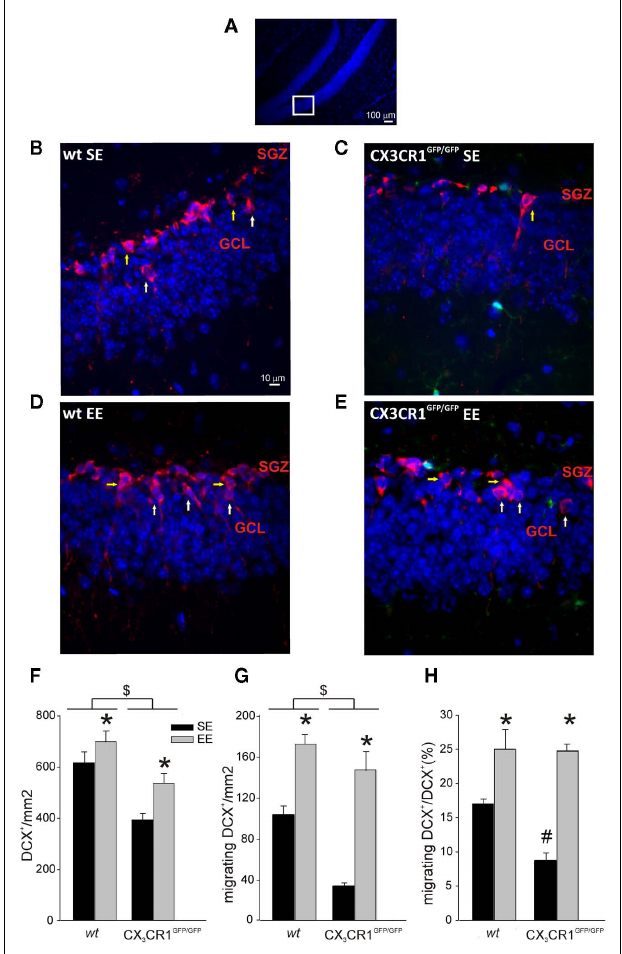
FIGURE 4 | Neuronal precursors in the DG of wt and CX 3 CR1 GFP/GFP mice. (A) Representative low-scale magnification of mouse hippocampal dentate gyrus (DG) coronal section stained for Hoechst (blue).The highlight square illustrates the DG regions amplified in (B–E) where DCX + cells are shown. Scale bar, 100 μ m. (B–E) Representative images of DCX + cells (red) in the DG of wt and CX 3 CR1 GFP/GFP mice, in SE and EE as indicated. Migrating DCX + cells are marked with white arrows, non-migrating cells with yellow arrows. Green cells in CX 3 CR1 GFP/GFP slice are microglia. Scale bar, 10 μ m. (F) Histograms showing the number of DCX + cells square millimeter in the DG of wt (left) and CX 3 CR1 GFP/GFP mice (right) in SE (top) and EE (bottom). *Is EE vs. SE and $ is CX 3 CR1 GFP/GFP vs. wt. ( p < 0.001). (G) Migrating DCX + cells square millimeter in the DG of wt and CX 3 CR1 GFP/GFP mice in SE and EE. *Is EE vs. SE and $ is CX 3 CR1 GFP/GFP vs. wt. ( p < 0.001). (H) Histograms showing the ratio between migrating vs. total DCX + in wt and CX 3 CR1 GFP/GFP mice in SE and EE. *Is EE vs. SE ( p < 0.001) and # is within SE